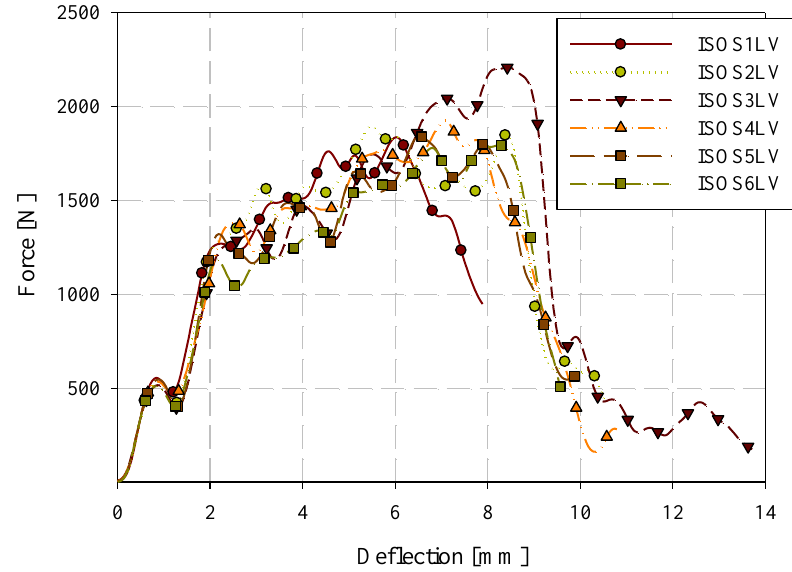
Figure 14. Filtered low-velocity impact puncture force-deflection responses.